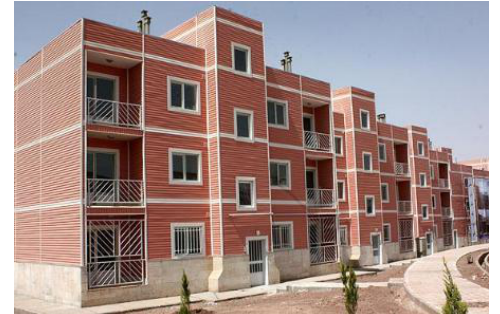
Figure 7 : Mehr housing project in Alborz city (author)